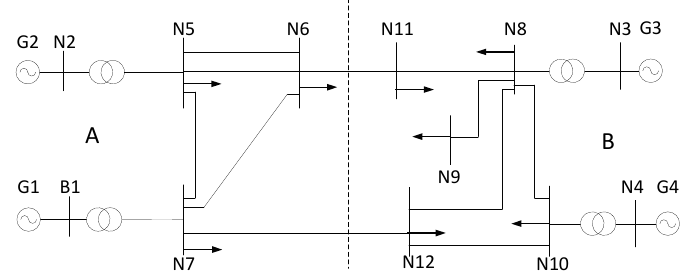
Figure 12. Simulation scenario of the power system.